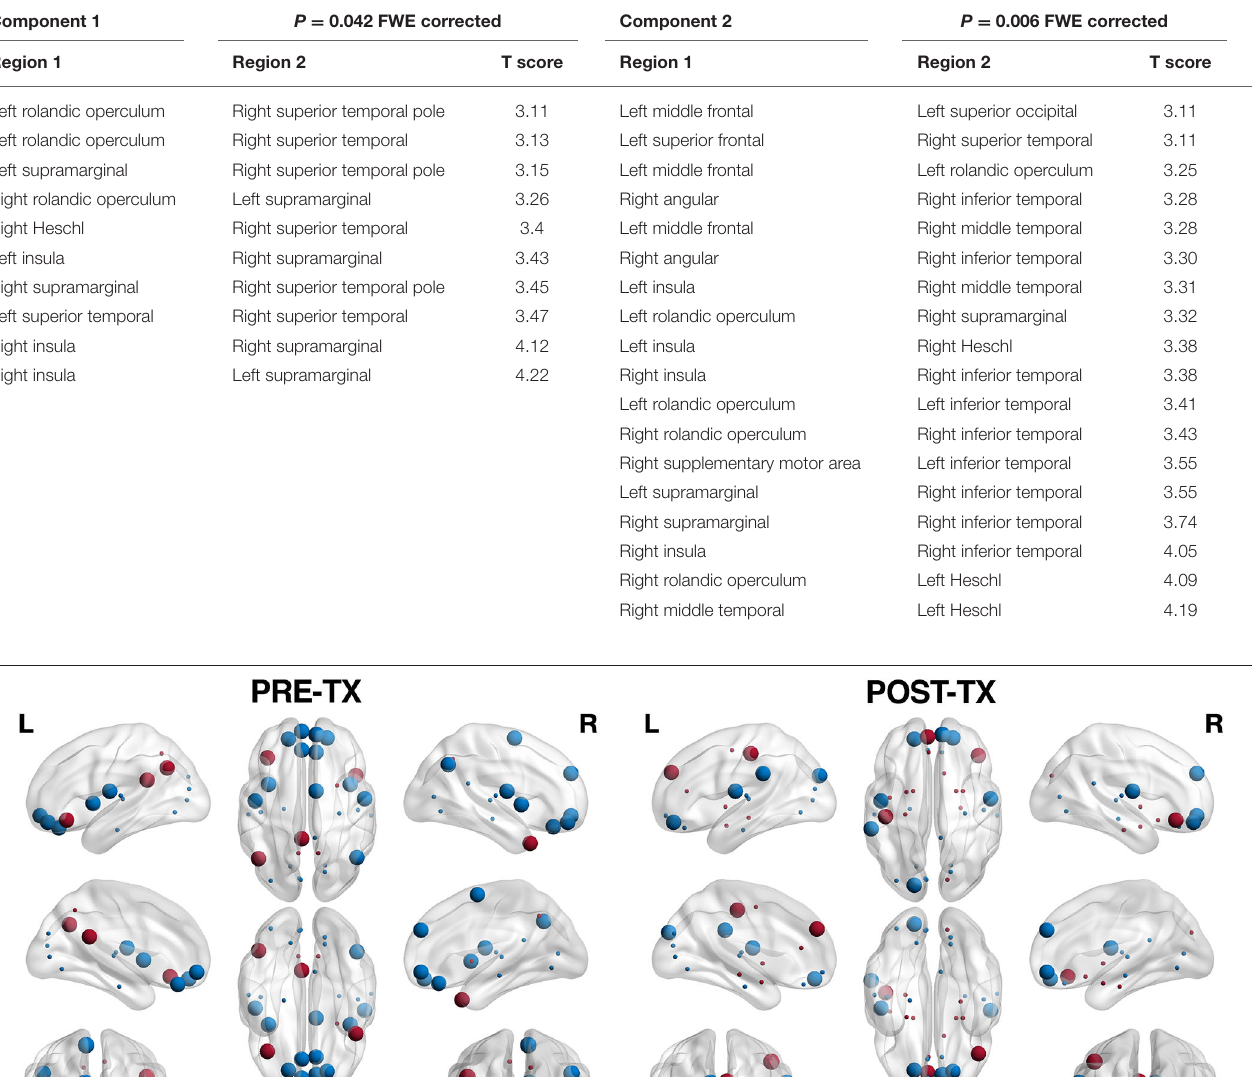
TABLE 2 | Network-based statistic results.